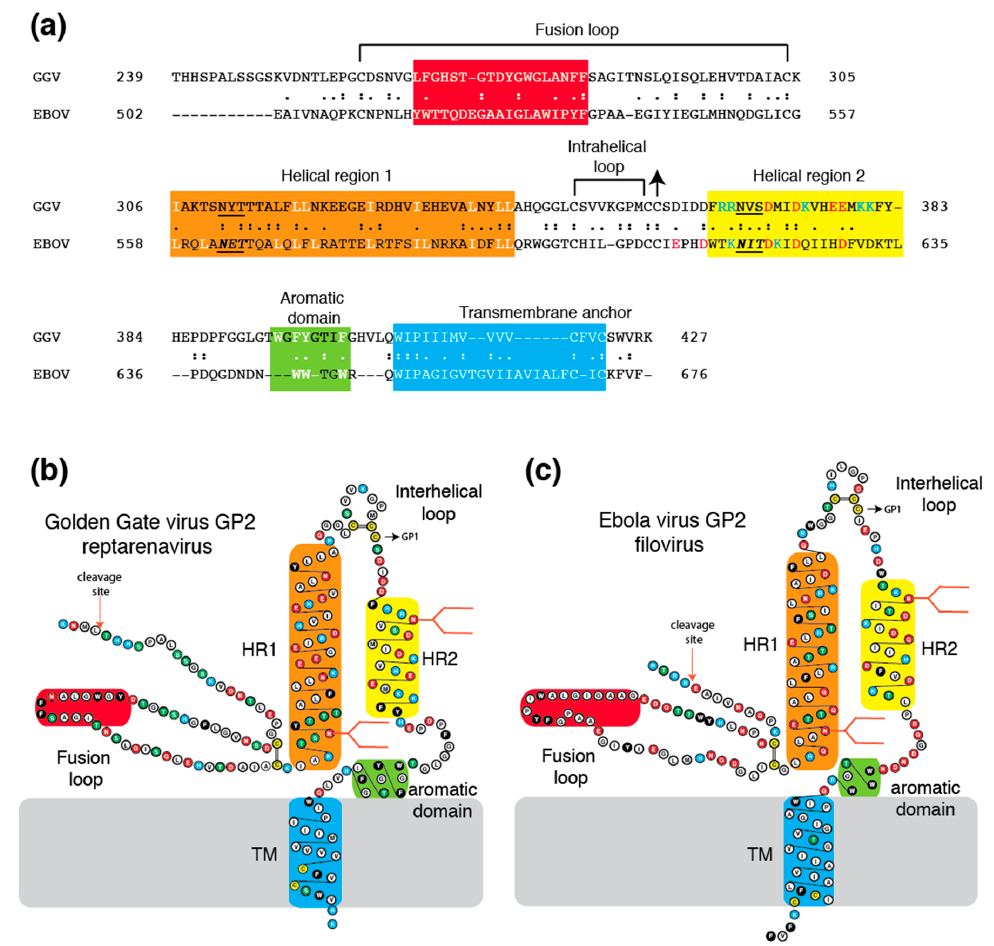
Figure 2. Comparison of glycoproteins of a reptarenavirus and a filovirus. Panel ( a ): Amino acid sequence alignment of glycoprotein 2 of Golden Gate virus (GGV, reptarenavirus) and Ebola virus (EBOV, filovirus). Panel ( b ): Two-dimensional model of GGV. Panel ( c ): Two-dimensional model of EBOV. Coloring and abbreviations as in Figure 1. Arrows indicate cysteine linkage to glycoprotein 1 (GP1).